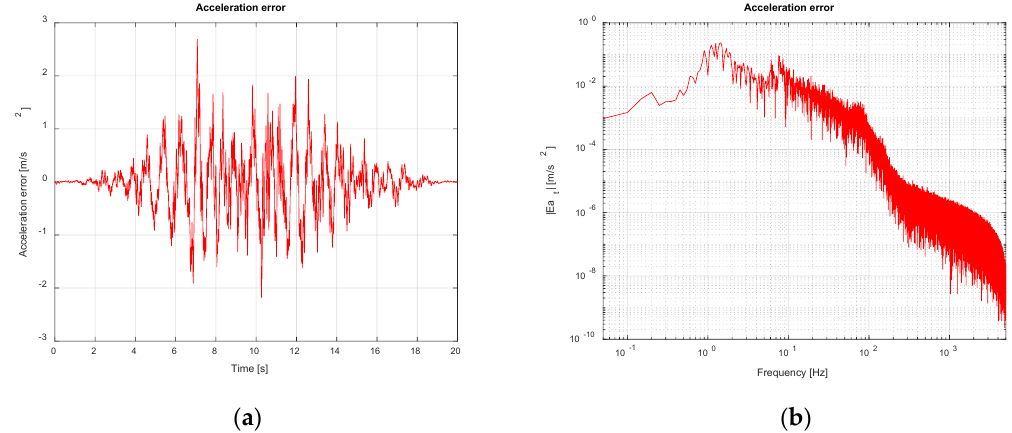
Figure 18. Shake table acceleration error (noise-free scenario). TVC disabled: ( a ) Time domain;